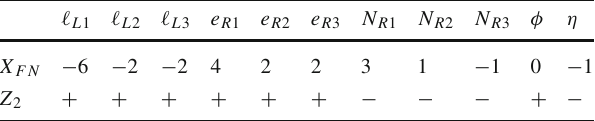
Table3 The U ( 1 ) FN chargeassignmentforleptons,right-handedneu- trinos, the Higgs doublet φ and an additional doublet scalar η . These are assumed to have no U ( 1 ) g